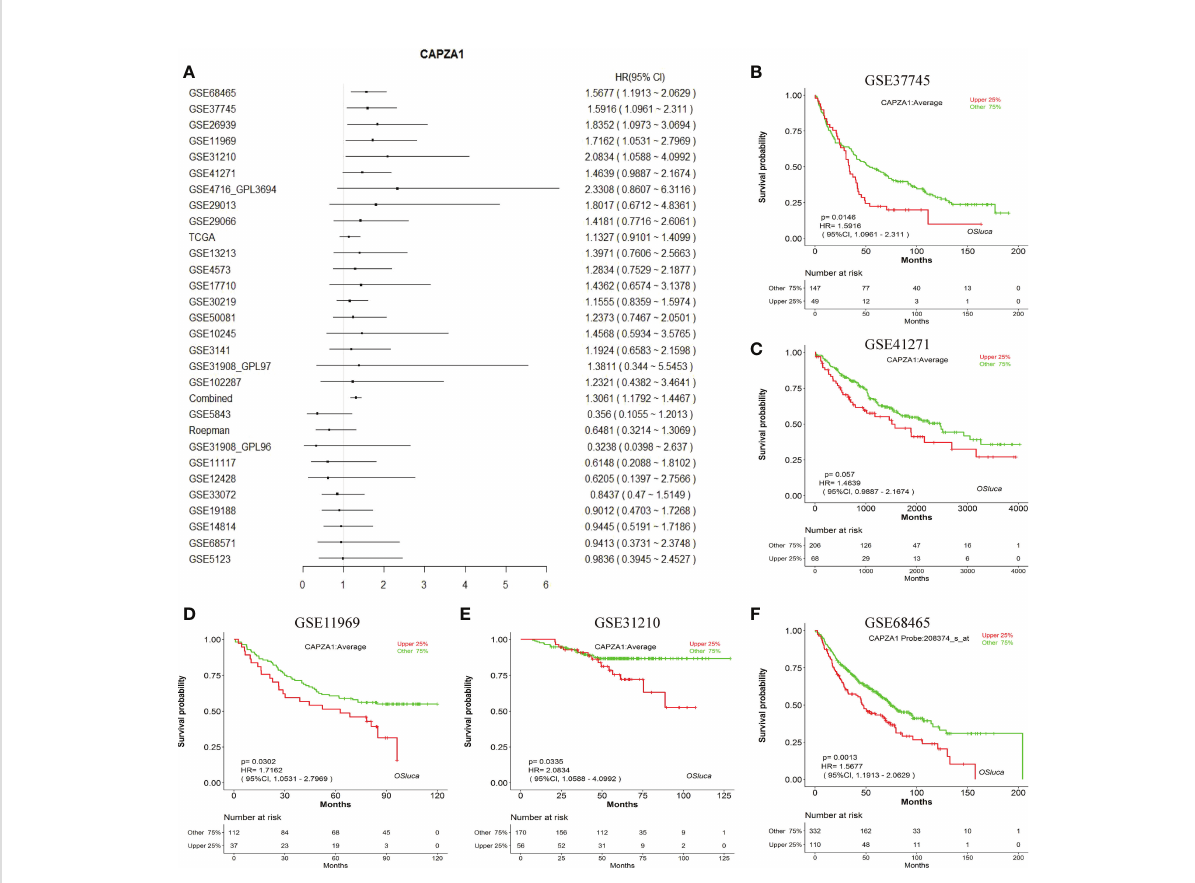
FIGURE 3 The prognostic value of CAPZA1. (A) Prognostic value of CAPZA1 in multiple data sets. (B – F) The representative survival curves.